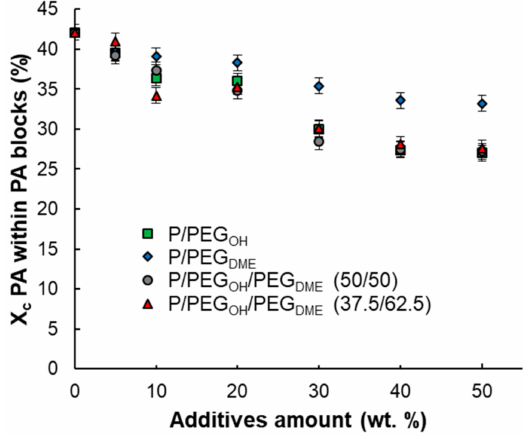
Figure 4. PA crystallinity within PA blocks as a function of additive amount.